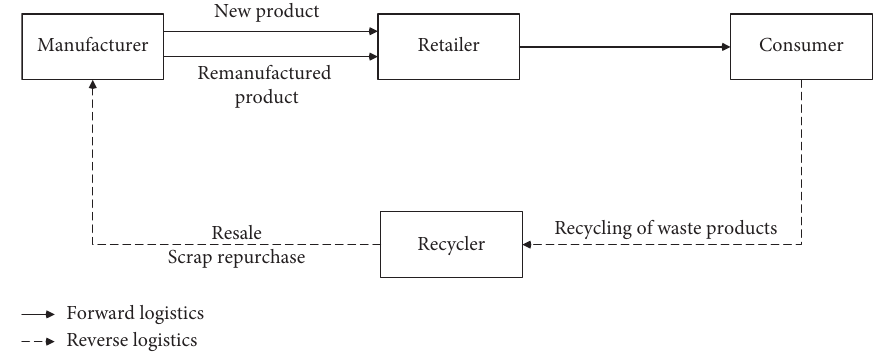
Figure 1: Operation mode of the closed-loop supply chain for